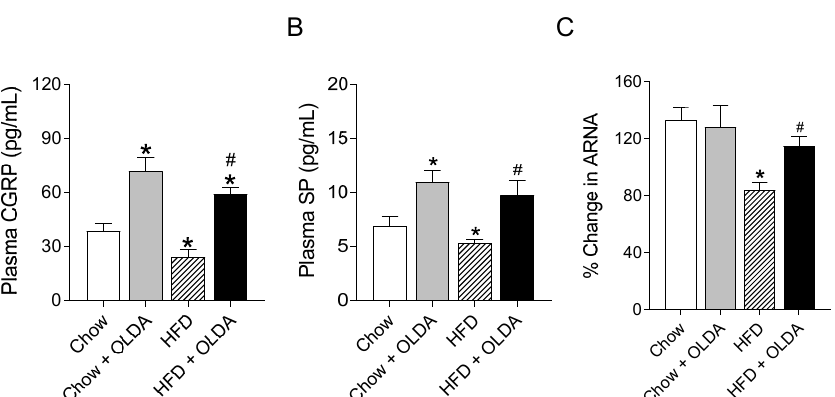
Figure 1. Effects of OLDA on glucose and insulin tolerance. The glucose tolerance test ( A ) and insulin tolerance test ( B ) in rats fed chow diet or high-fat diet (HFD) by the end of the 8 week treatment with or without intrathecal N-oleoyldopamine (OLDA) treatment (1 ng/kg, daily). Blood from the tail was collected to measure the level of blood glucose before and after intraperitoneal injection of glucose (2 g/kg) in rats with 15 h fasting or insulin (0.75 IU/kg) in rats with 6 h fasting, respectively. Values are means ± SE (n = 8). * p < 0.05 compared with that of the chow group. Figure 2